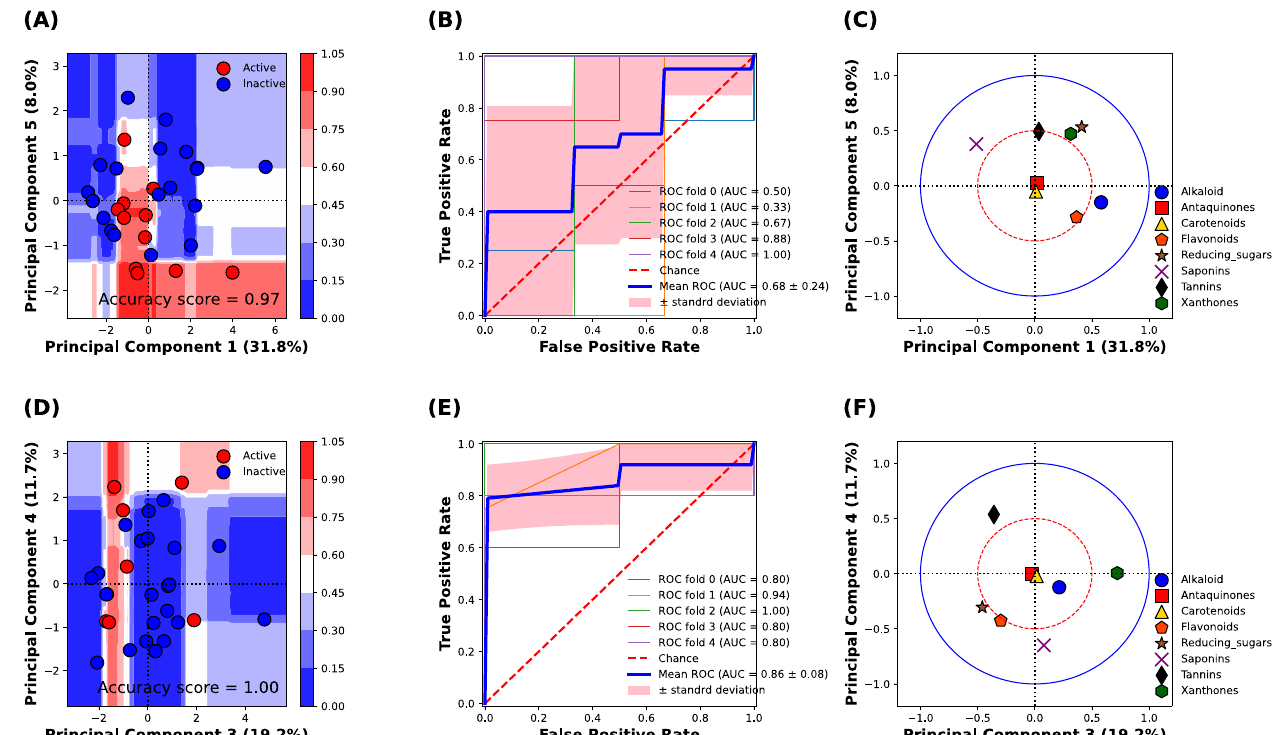
Figure 3. Classification analysis based on the random forest model of 31 TTM plant samples against α -amylase and α -glucosidase enzymes. ( A ) Decision boundary and score plot between principal component 1 (PC1) and component 5 (PC5) to predict the α -amylase inhibitory activity. Blue and red surfaces or dots indicate the inactive and active α -amylase inhibitory activity. ( B ) Receiving operating characteristic (ROC) of 5-fold cross-validation on the prediction of amylase inhibitory activity. ( C ) Loading plot of principal component analysis between PC1 to PC5. The blue solid circle indicates the correlation of the component in PC1 and PC5 at 1.0, and the red dash circle indicates the correlation of the component in PC1 and PC5 at 0.5. ( D ) Decision surface and score plot between principal component 3 (PC3) and component 4 (PC4) to predict the α -glucosidase inhibitory activity. Blue and red surfaces or dots indicate the inactive and active α -glucosidase inhibitory activity. ( E ) Receiving operating characteristic (ROC) of 5-fold cross-validation on the prediction of α -glucosidase inhibitory activity. ( F ) Loading plot of principal component analysis between PC3 to PC4. The blue solid circle indicates the correlation of the component in PC3 and PC4 at 1.0, whereas the red dash circle indicates the correlation of the component in PC3 and PC4 at 0.5.